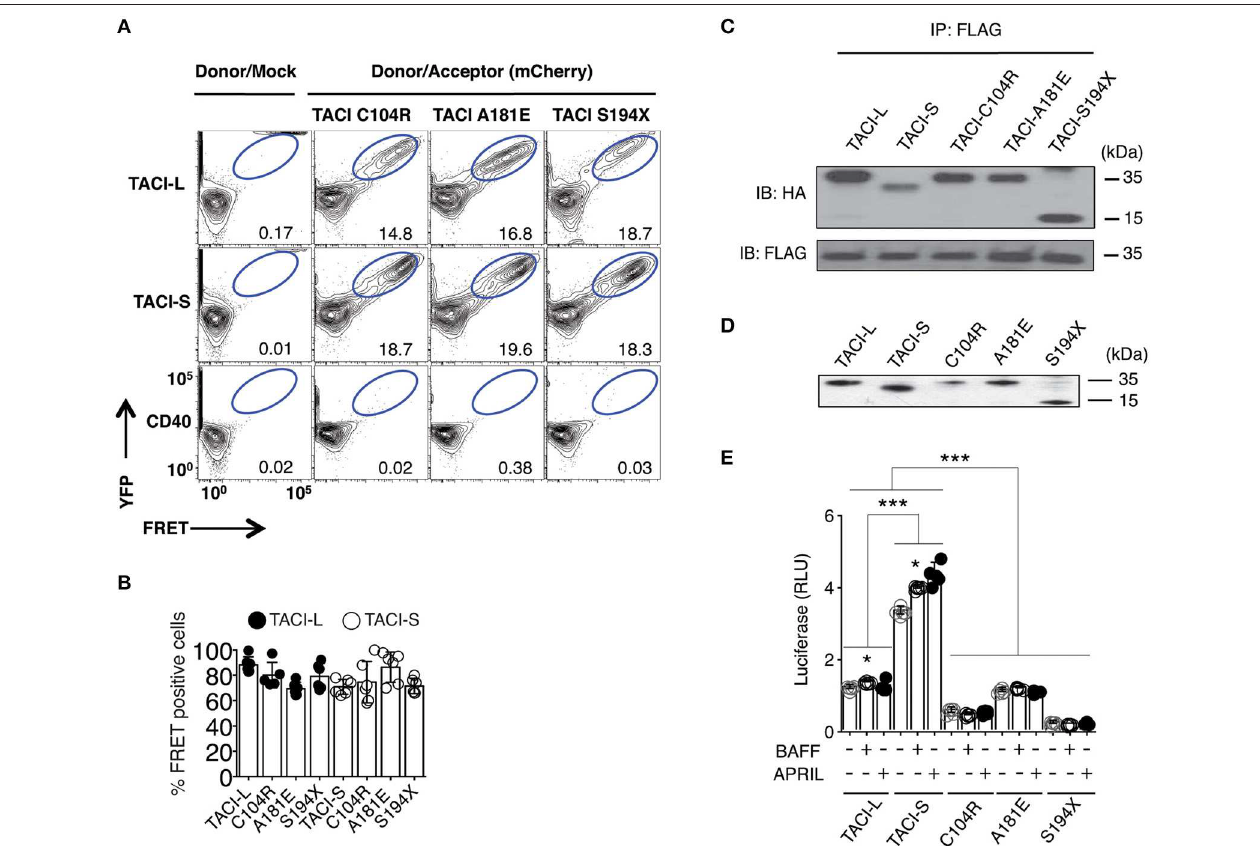
FIGURE 2 | TACI variants with missense mutations bind un-mutated isoforms but lack signaling function. (A) TACI mCherry labeled mutants, C104R, A181E, and S194X were generated in the TACI-L and TACI-S isoforms, and co-transfected into HEK-293T cells with WT TACI-YFP. These were examined in FRET experiments by FACS (LSRII) to judge complex formation using CD40-eYFP as a control. The dot plot results in each panel, are shown for one sample, representative of the results for 6 different experiments. The numerical data given in each panel, are the percent of FRET positive cells, of the live cells in the gate, averaged for all 6 experiments. (B) Frequency of FRET positive cells in the double positive YFP and mCherry gate. Data shows average ± SD from 6 independent experiments. In other experiments, ligands, APRIL, or BAFF (0, 5, 20, or 50ng/ml) were added to judge the effects on FRET signal, showing no alteration in the signal (not shown). (C) For validation of complexes found in FRET, complexes forming with FLAG-TACI were precipitated with anti-FLAG sepharose beads and run on 10% PAGE gels; immunoblots were developed with an anti-HA antibody. Lower panel shows FLAG expression control. (D) To examine NF-kB luciferase induction, TACI-S, TACI-L or mutant C104R, A181E and S194X constructs were transfected into HEK-293T cells, along with NF-kB–luc reporter and control pRL-null plasmids and cultured for 48h; TACI expression was confirmed by western blot. (E) These cells were cultured with or without activation for 6h with 100ng/ml APRIL or BAFF. Reporter gene activity was determined, and NF-kB luciferase induction normalized to Renilla luciferase. Values reported are represented as Relative Luciferase Activity (RLA) and are the mean ± SD from 5 to 7 independent experiments. * p < 0.05; *** p < 0.001, two-tailed paired Student t -test. Western blot shows that all constructions are expressed.